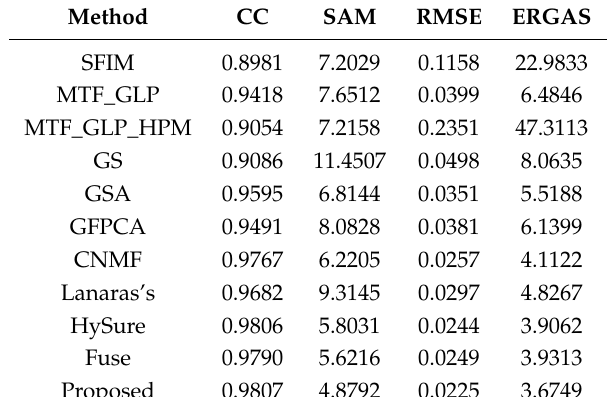
Table 2. Objective performance of eleven methods on the Moffett Field data set.